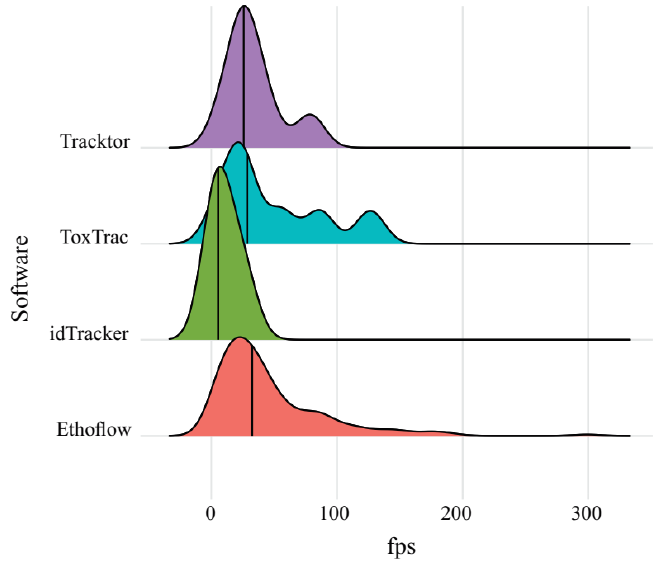
Figure 9. Distribution of frames per second rate exhibited for tracking software. The vertical lines within the density curves show the median. Statistical interaction was observed between the variables video resolution and group size in fps rate (F 1, 130 = 12.81, p = 0.0005, Figure 10A). The heterogeneous environ- ment quantification was not influenced by the video resolution or number of individuals (F 1, 28 = 0.81, p = 0.37, Figure 10B), and the fps rate in a heterogeneous environment (0.386) was lower than in homogeneous backgrounds. The fps decreased with an increase in the centrality of individuals (F 1, 38 = 81.24, p < 0.0001, Figure 10C). There was no significant effect on the number of individuals (F 1, 37 = 0.009, p = 0.93), and no interaction was ob- served between the centrality and individuals (F 1, 36 = 1.62, p = 0.21). Besides, the software exhibited high detection rates with significant interaction between the number of individ- uals and type of background (F 1, 94 = 137.85, p < 0.0001, Figure 10D), where an increase in the number of individuals had a greater influence on the heterogeneous environments.